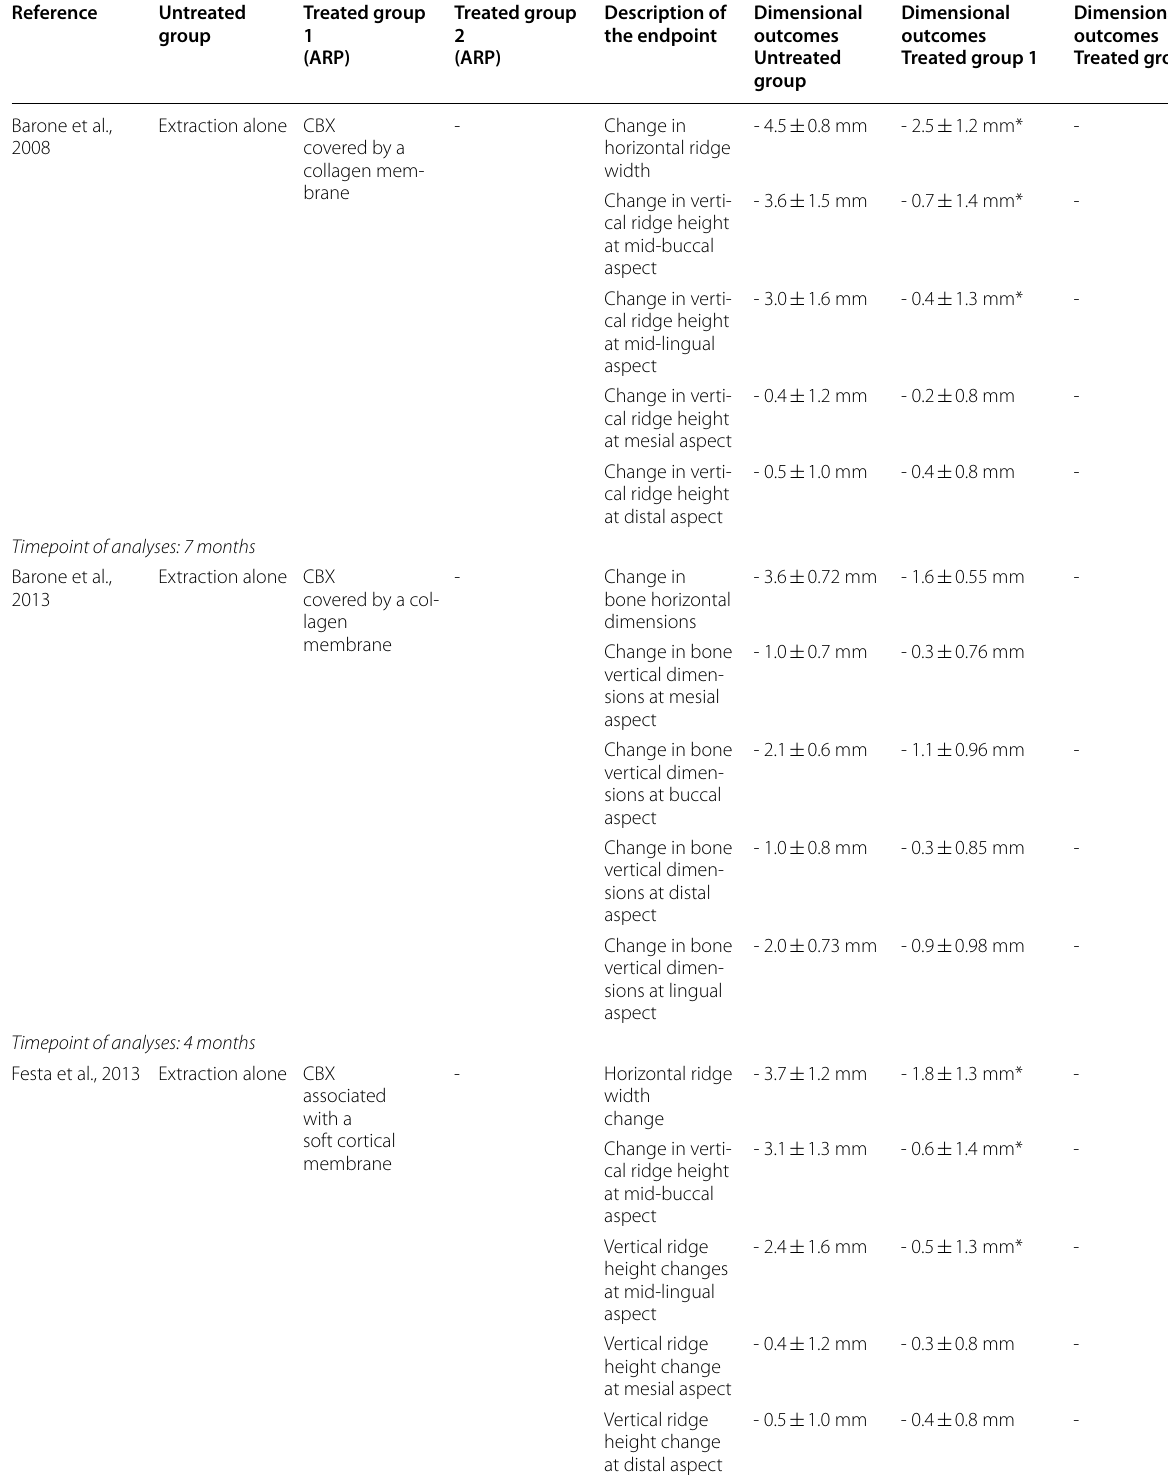
Table 3 Dimensional changes of the alveolar ridge after ARP procedures with CBXs. Data are presented as Mean